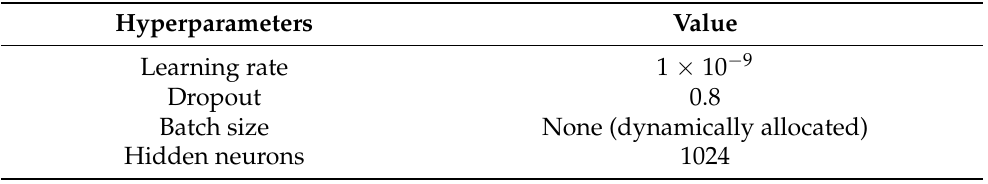
Table 4. Hyperparameters of the proposed